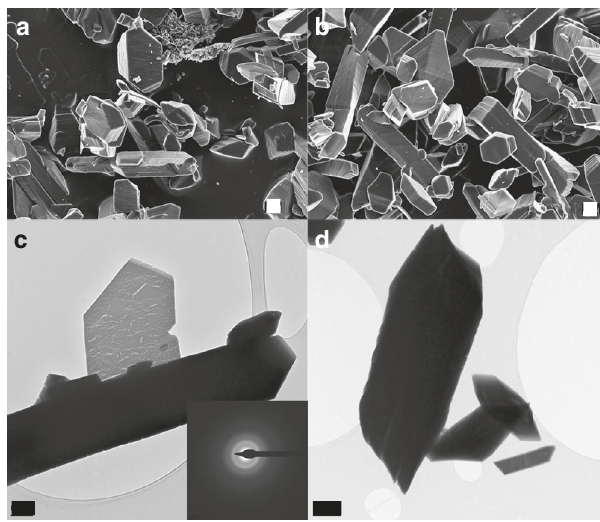
Fig. 3 Characterization of calcium oxalate precipitates (control runs). FESEM ( a , b ) and TEM ( c , d ) images of calcium oxalate particles (mostly